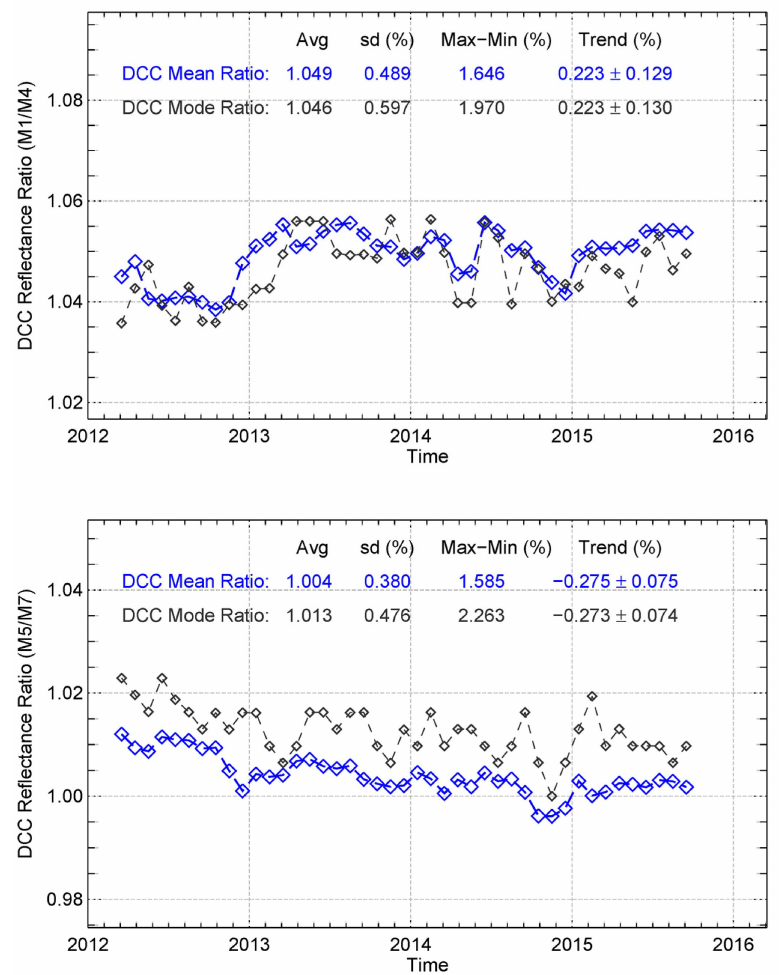
Figure 7. Monthly DCC band ratio time series for M1/M4 and